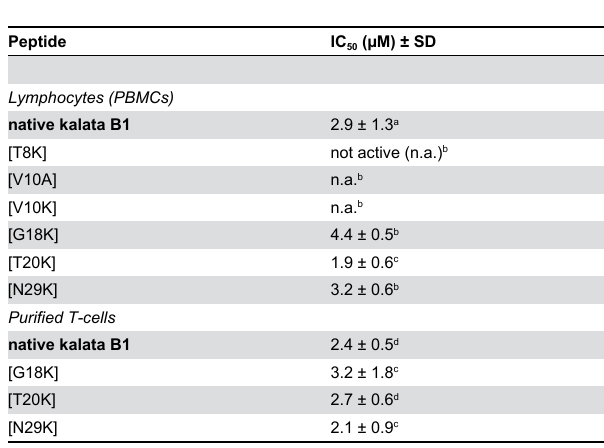
Table 1. Potency of kalata B1 and mutants to inhibit lymphocyte and purified T-cell